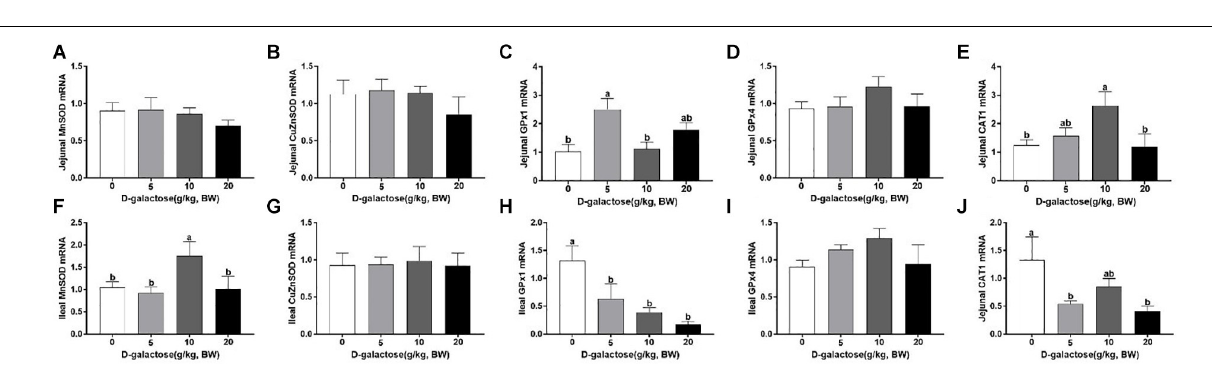
FIGURE 11 | Effects of D -galactose on intestinal expressions of MnSOD, CuZnSOD, GPx1, GPx4, and CAT1. (A–E) mRNA abundances of MnSOD, CuZnSOD, GPx1, GPx4, and CAT1 in the jejunum; (F–J) mRNA abundances of MnSOD, CuZnSOD, GPx1, GPx4, and CAT1 in the ileum. Data were expressed as the mean ± SEN. Different lower-case letters indicate a significant difference among different dosage of d-galactose ( P <